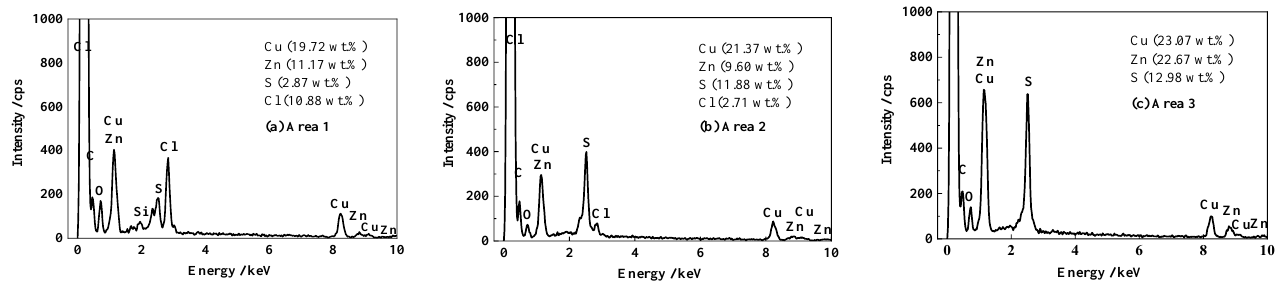
Figure 4. SEM morphology of FW1 coating sample after 1700 d: ( a ) the surface of antifouling coating; ( b ) cross-section of coating sample. ( b ) cross-section of coating sample.